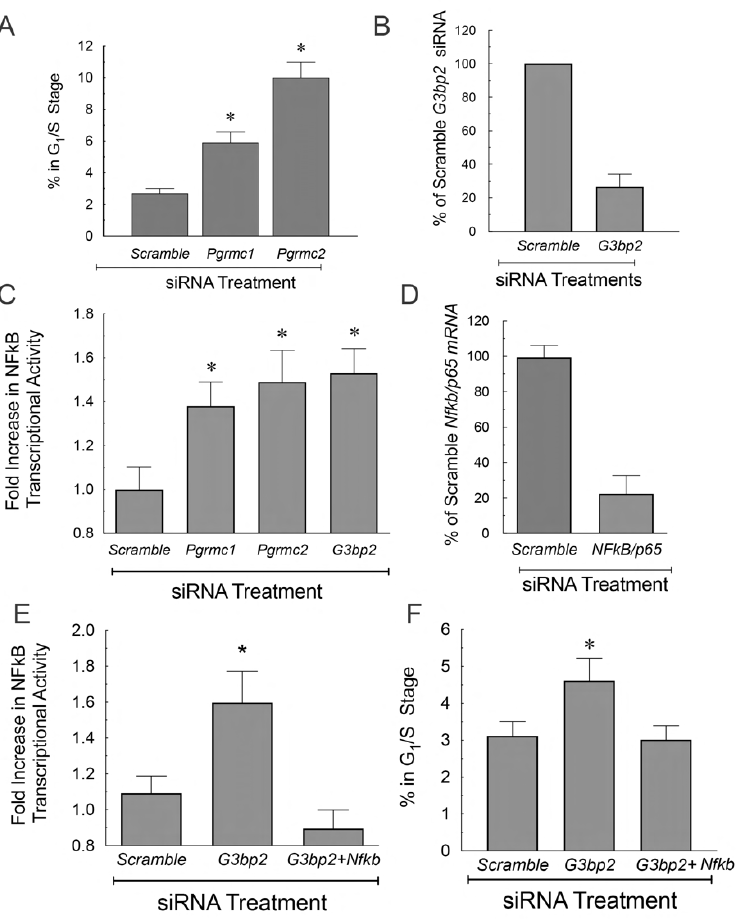
Figure 5. The effect of Pgrmc1 and Pgrmc2 siRNA treatment on the percentage of SIGCs entering the cell cycle ( A ). Panel ( B ) shows the effect of G3BP2 siRNA on the mRNA levels of G3BP2. The effect of Pgrmc1 , Pgrmc2 , and G3BP2 siRNA treatment on NFkB transcriptional activity as assessed by a GFP reporter construct ( C ). The effect of NFkB siRNA on NFkB mRNA levels ( D ) and the effect of NFkB siRNA in the presence of G3BP2 siRNA on NFkB transcriptional activity ( E ) and entry into the G 1 /S phase of the cell cycle ( F ). Data taken from Peluso et al. [87]. * indicates a value significantly different from scramble control.